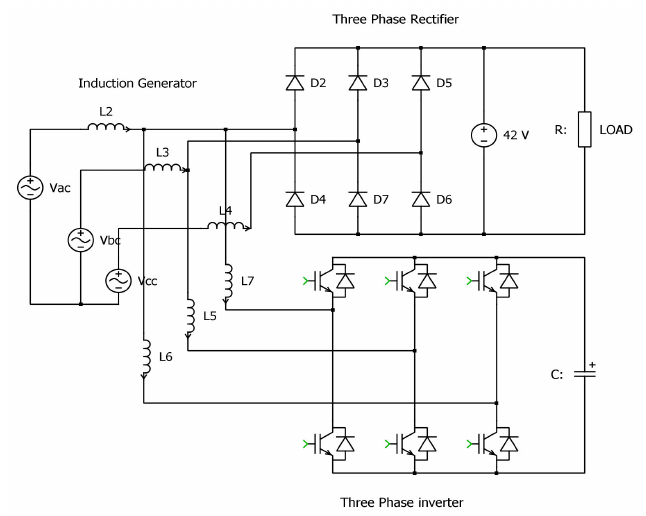
Figure 34. Induction generator with inverter and bridge rectifier